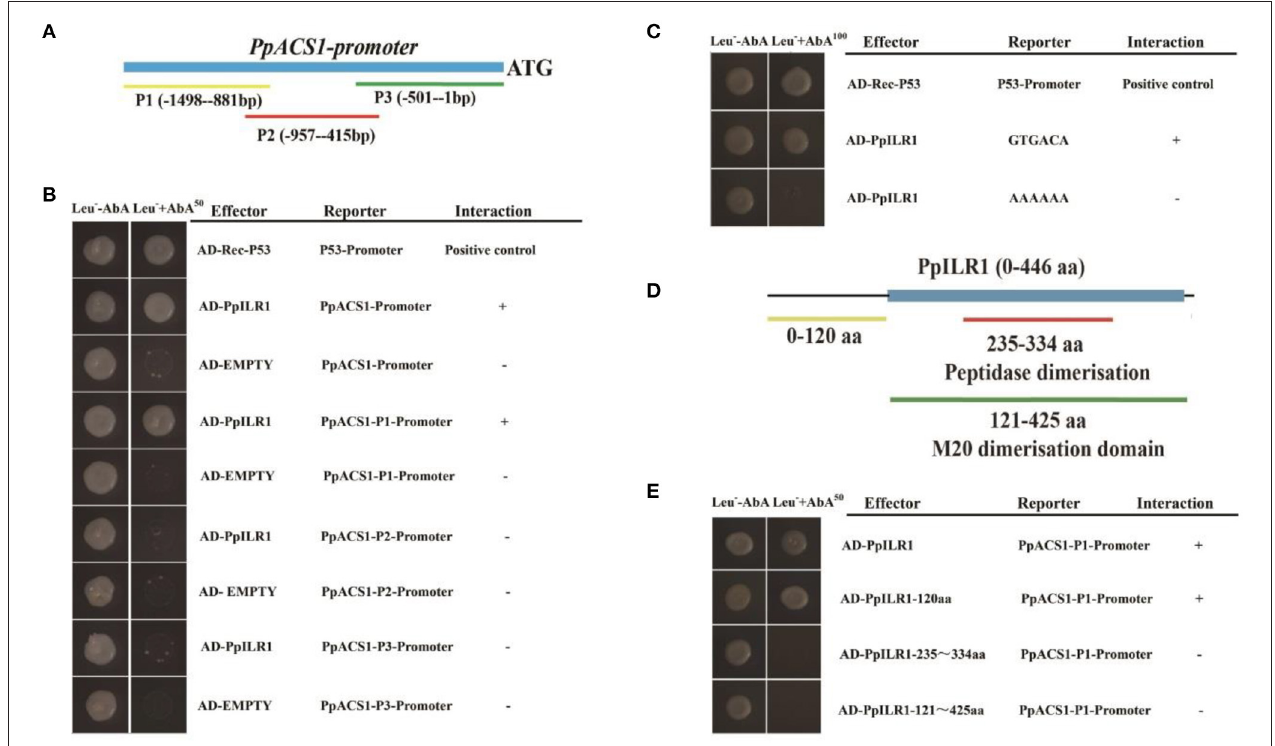
FIGURE 1 | PpILR1 binds directly to the PpACS1 promoter. (A) The PpACS1 promoter was divided into three fragments. (B) Yeast one-hybrid (Y1H) analysis. Aureobasidin A (AbA; 50ng/ml) was used as a selection marker. The Rec-P53 and P53 promoters were used as positive controls. The empty vector with the PpACS1 promoter fragments was used as a negative control, and showed no interaction. (C) Y1H analysis showing that PpILR1 binds to the GTGACA element. (D) The PpILR1 protein was divided into three fragments. (E) Y1H assay showing that the PpILR1–120aa fragment (N-terminus) interacts with the PpACS1-P1 promoter fragment.